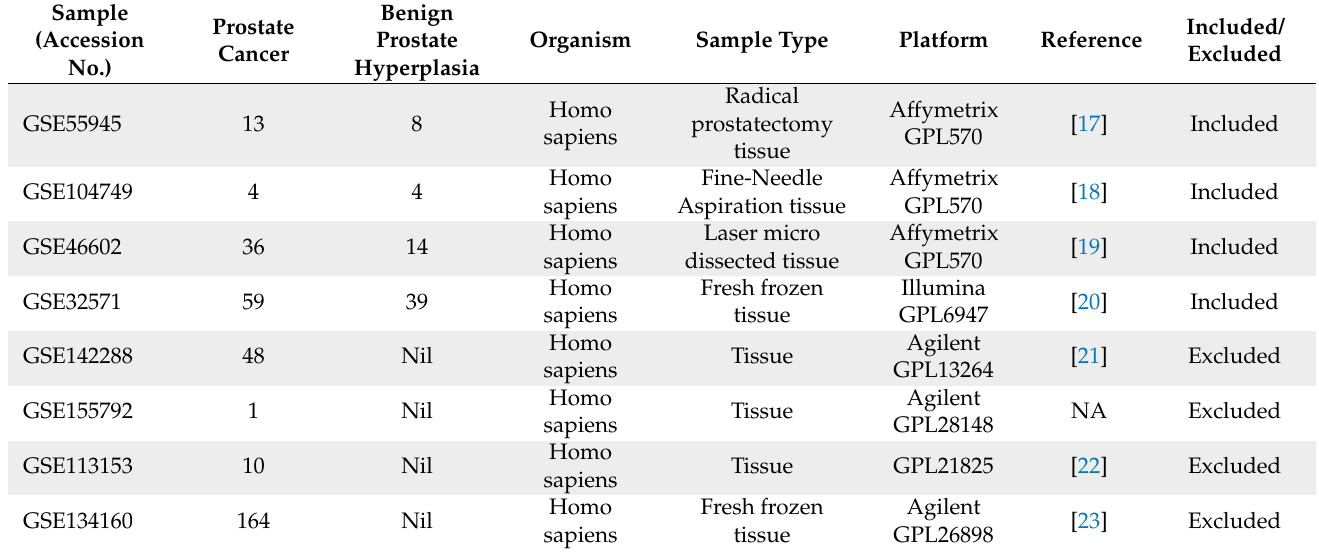
Table 1. Information about the included GSEs in this